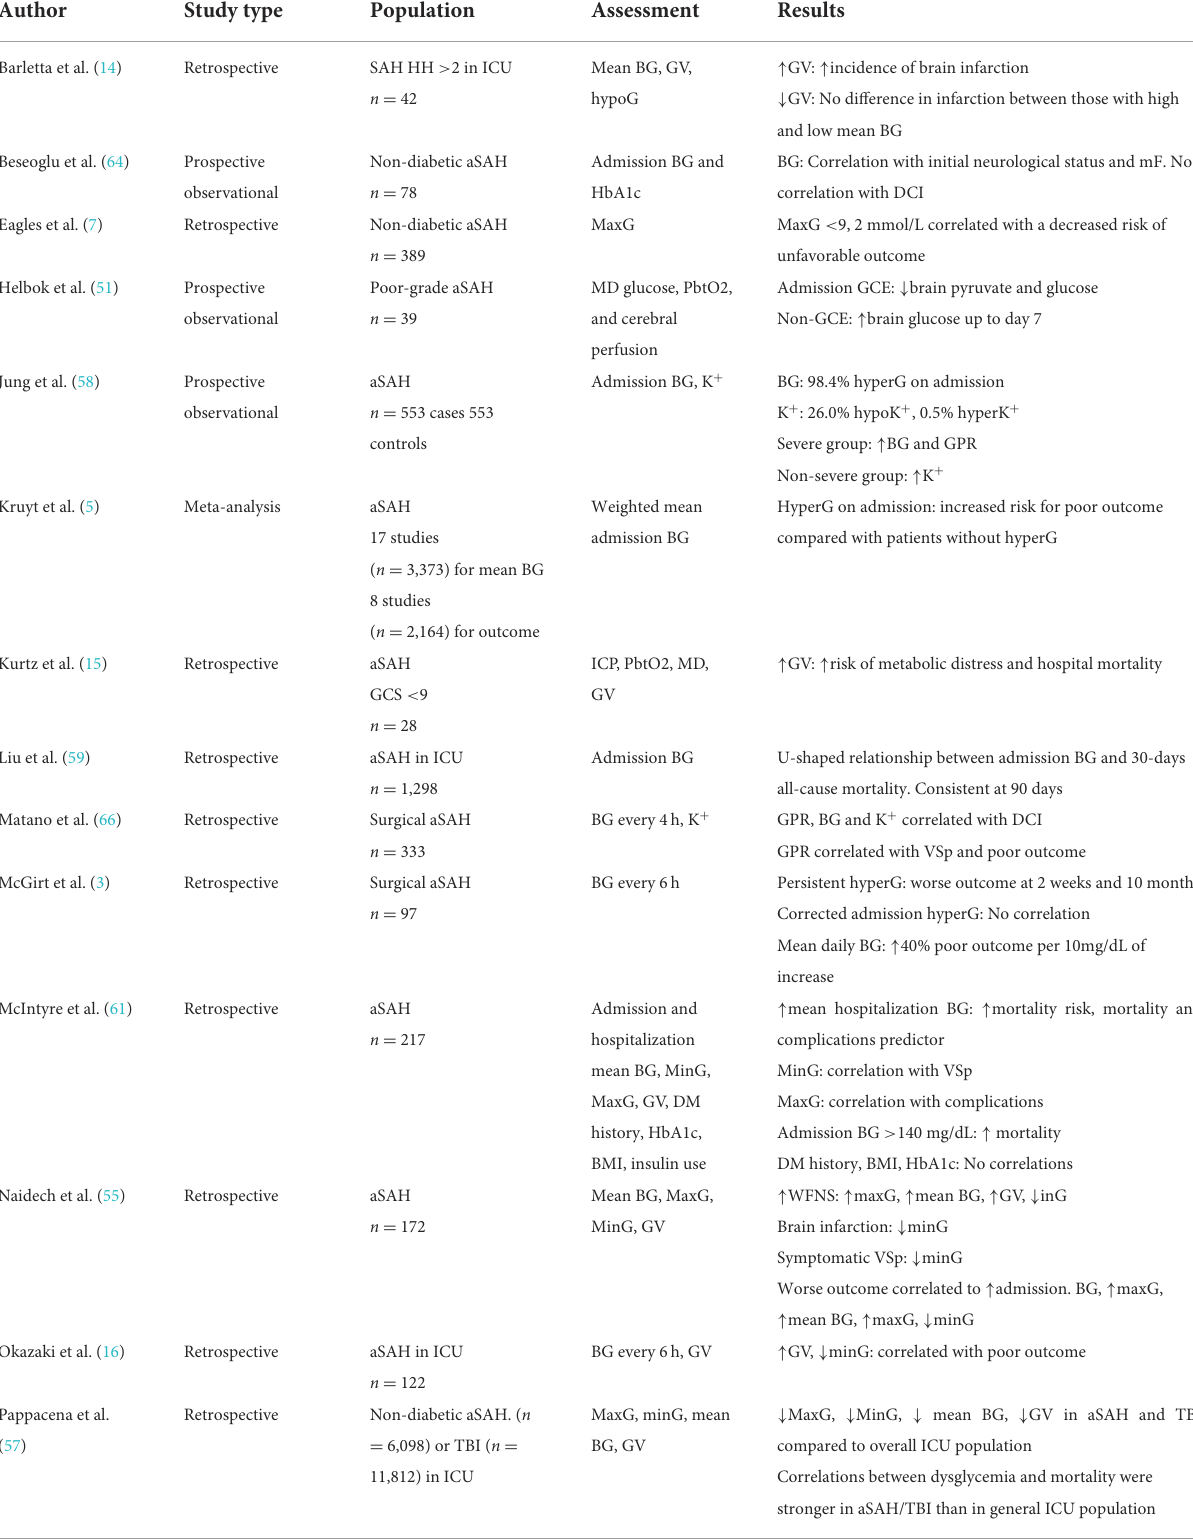
TABLE 1 Main studies assessing the impact of glucose and brain metabolism in prognosis and complications after spontaneous